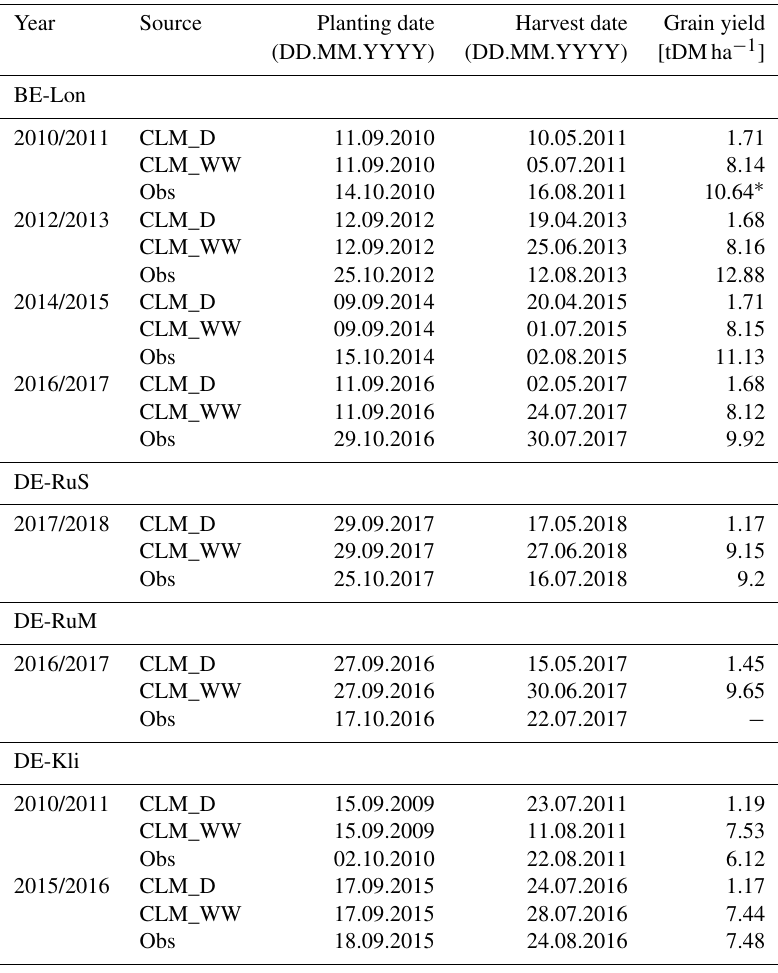
Table 3. Simulated annual planting and harvest dates and grain yield (tDMha − 1 ) by CLM_WW and CLM_D simulations (calculated using the peak daily grain carbon throughout the growth cycle) compared to recorded harvest dates and grain yield (Obs) for all simulated winter wheat years at the sites BE-Lon, DE-RuS, DE-RuM, and DE-Kli. For CLM simulation results, grain yield is calculated from grain carbon, which is assumed to be 45% of the total dry